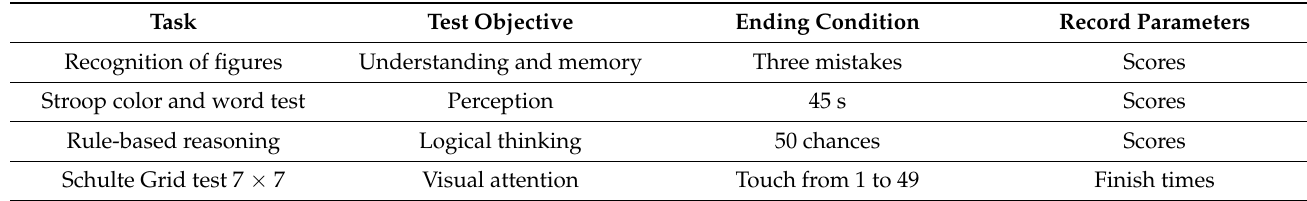
Table 5. Detailed recorded parameters for four